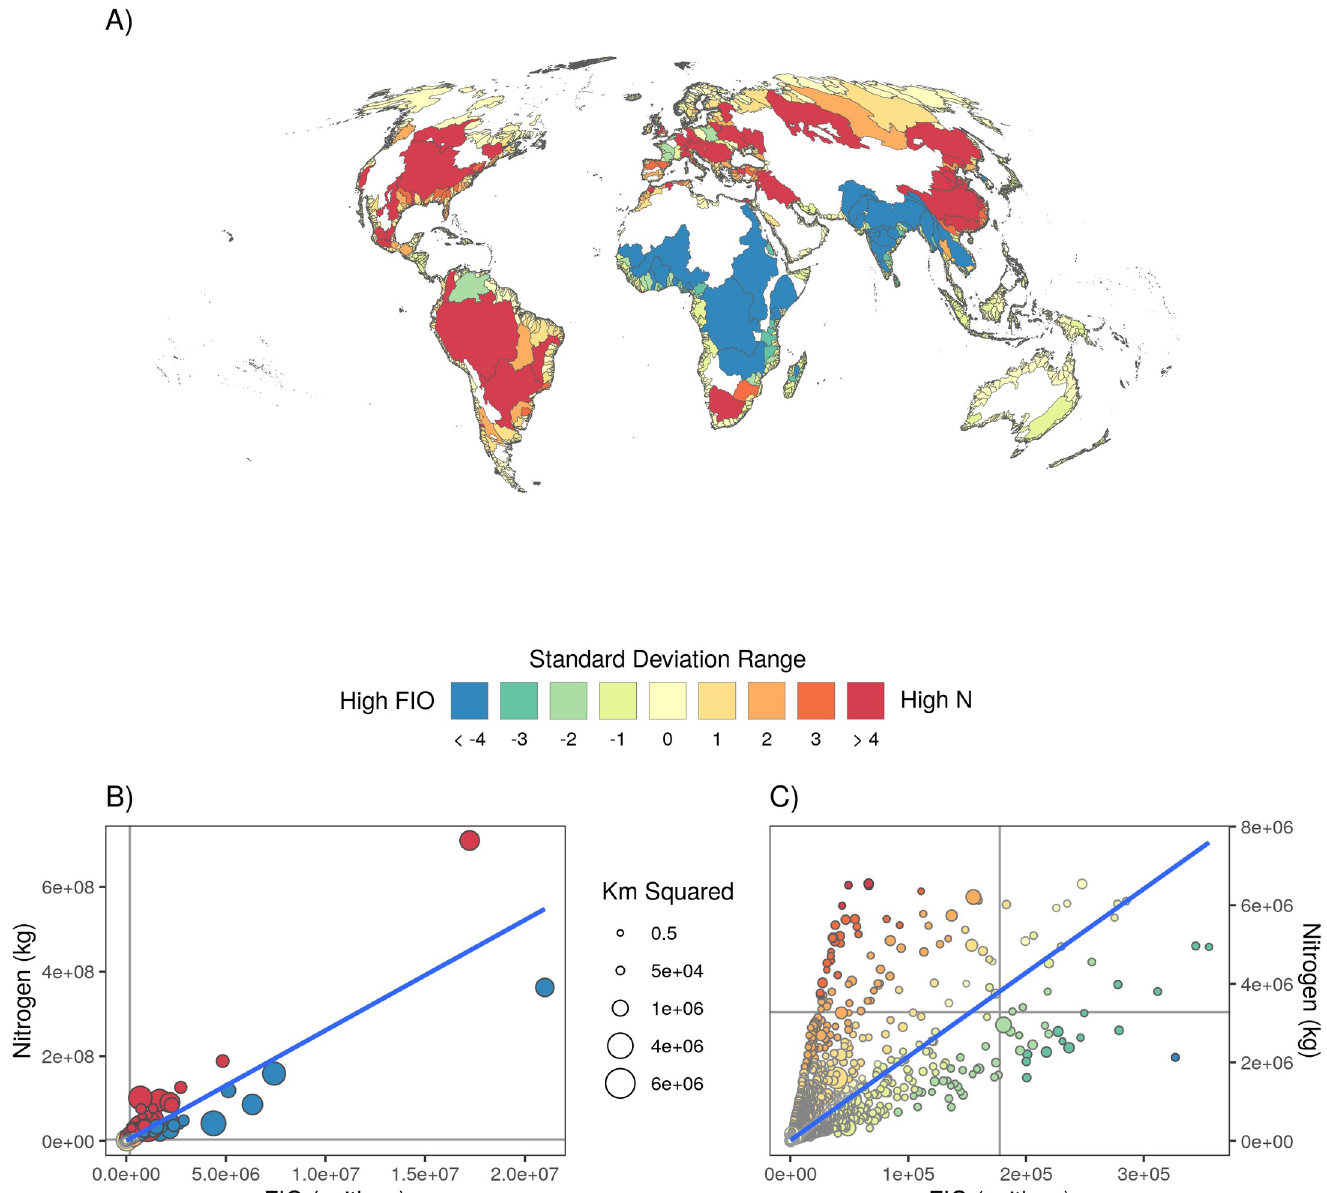
Fig 4. The relationship between watershed level input of N versus FIO. Watersheds for which total N exceeds (yellow to red colors) or is well below (green to blue colors) expected levels given predicted nitrogen/pathogen outputs from their correlation. Global map (A) and scatterplots of all watersheds, both full extent (B) and zoomed in (C). Watersheds for which the levels are proportional to expectations are white in the map, inclusive of the nearly 50% of (very small) watersheds for which there is no nitrogen or pathogen inputs. Dots in the scatter plot are scaled to the size of the